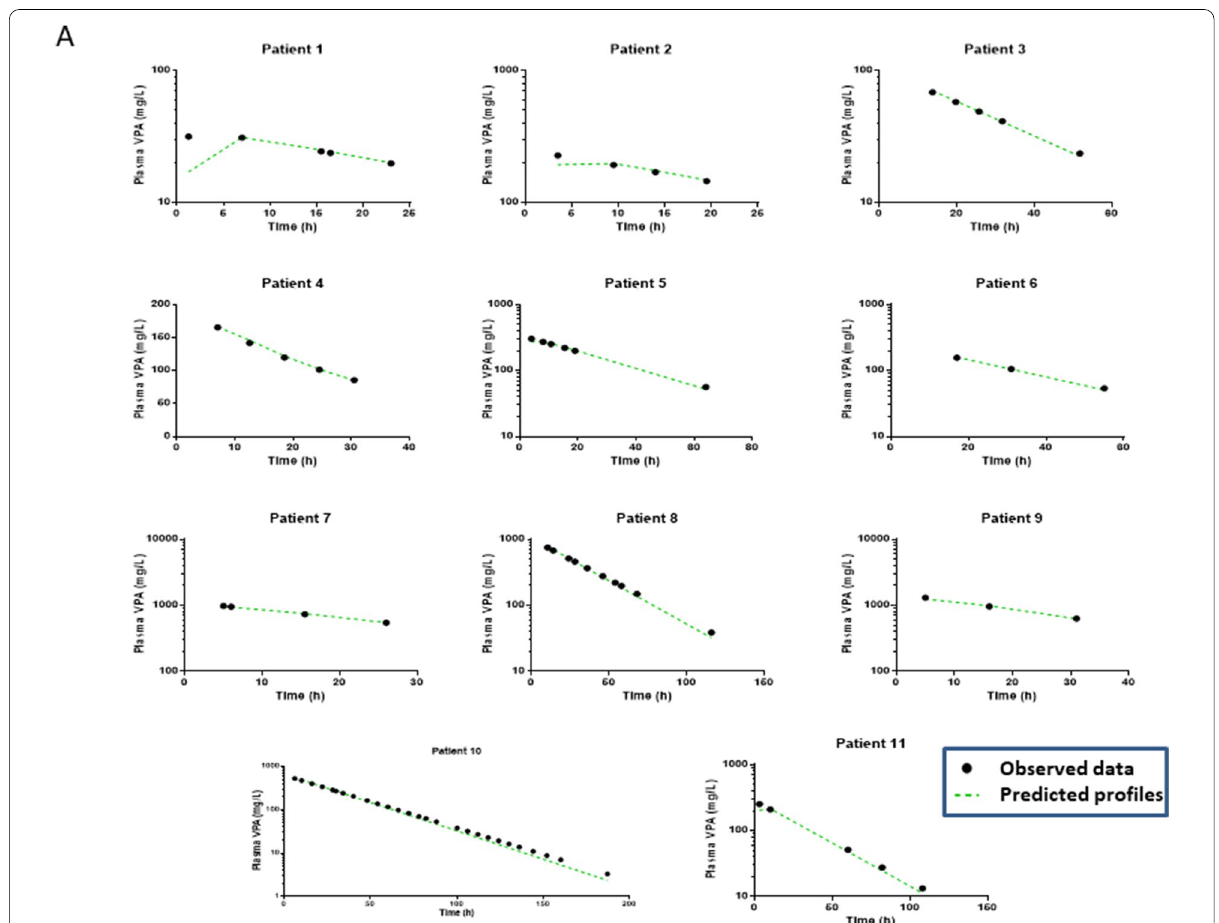
Fig. 2 Individual toxicokinetics showing the best fit of the observed values in nineteen valproic acid (VPA)-poisoned patients non-treated (panel A ) or treated with L-carnitine (designated as LC, panel B